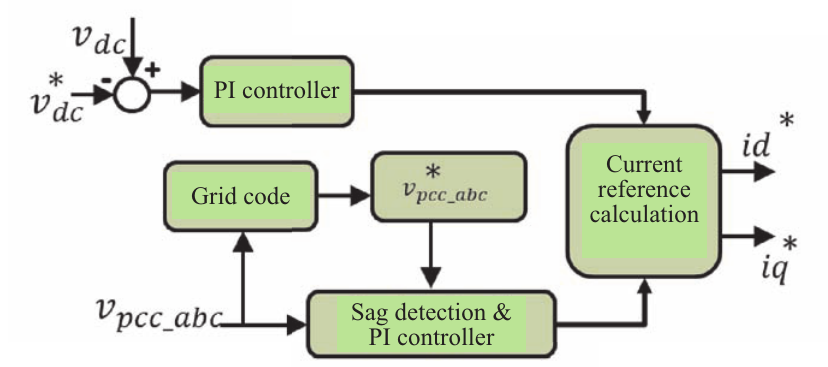
Sag detection & PI Fig. 2. Current reference calculation.